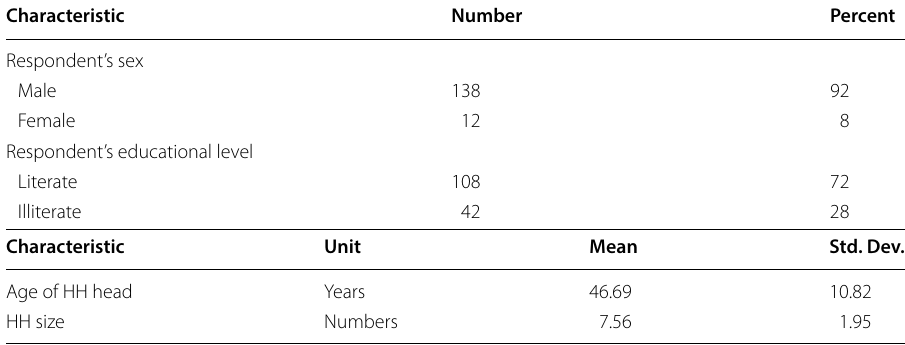
Table 2 Demographic characteristics of the sample households. Source: Computed from Field Survey Data,